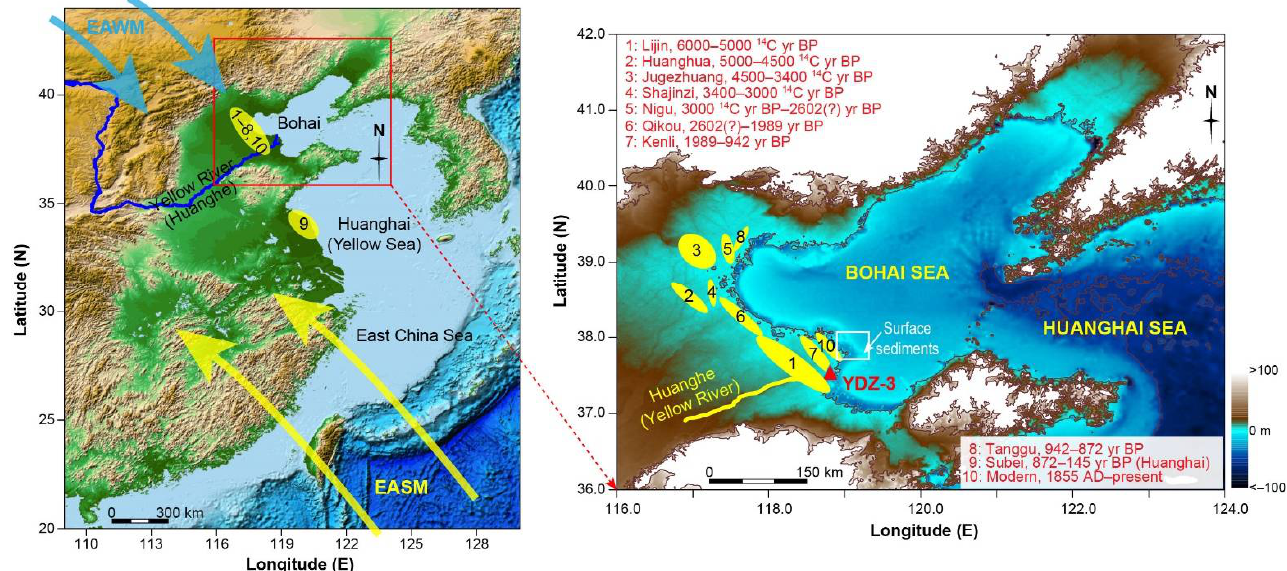
Figure 1. Study area, paleo-superlobes [10,11,13], and YDZ–3 location. The ten paleo-superlobes of the Yellow River delta in the Holocene are labeled as numbers. Marine surface sediments in the Yellow River estuary [14] were analyzed for reference. EASM, East Asian summer monsoon; EAWM, East Asian winter monsoon. The base map data was generated using the open and free software DIVA–GIS 7.5 (http://www.diva-gis.org/, accessed on 20 March 2021).